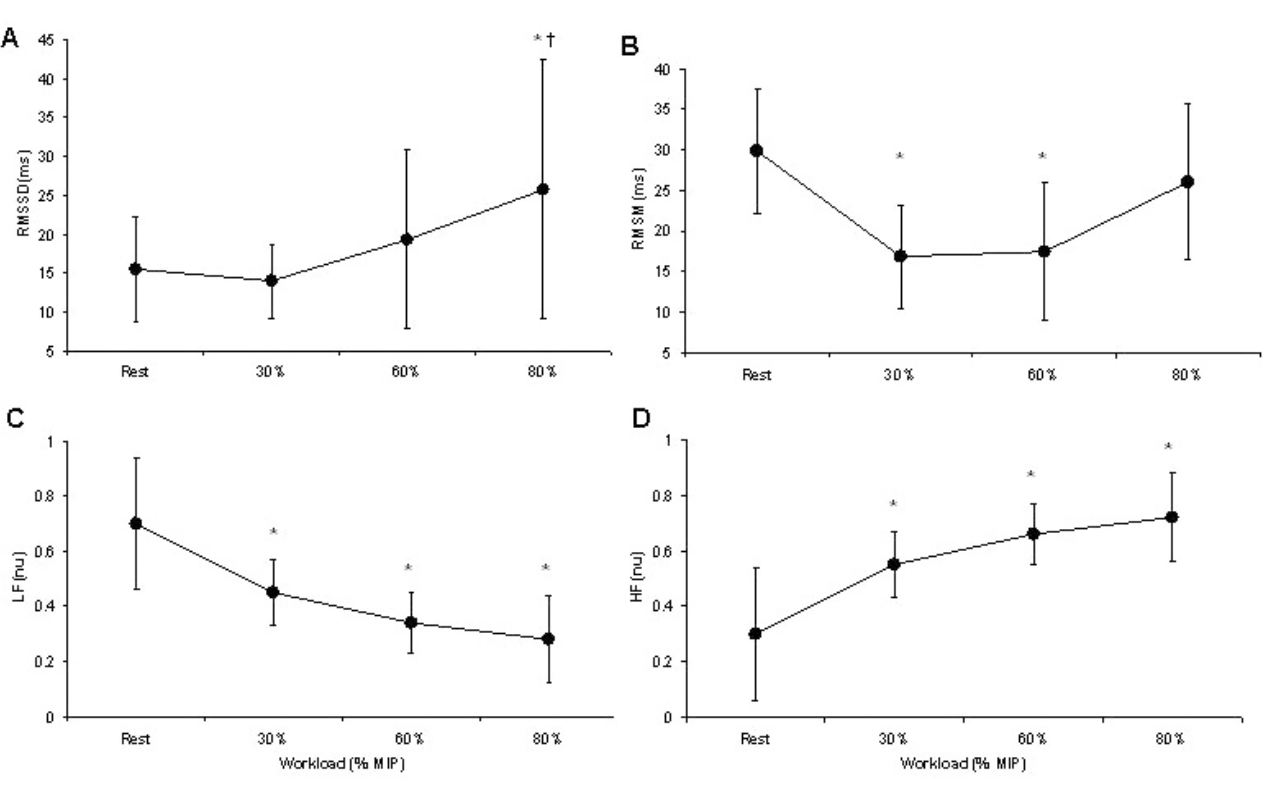
Fig. 1 – Comparison of heart rate variability index at rest, 30%, 60% and 80% of maximal inspiratory pressure during endurance protocol. Data expressed in mean and standard deviation. MIP=maximal inspiratory pressure; LFnu=low frequency in normalized units; HFun=high frequency in normalized